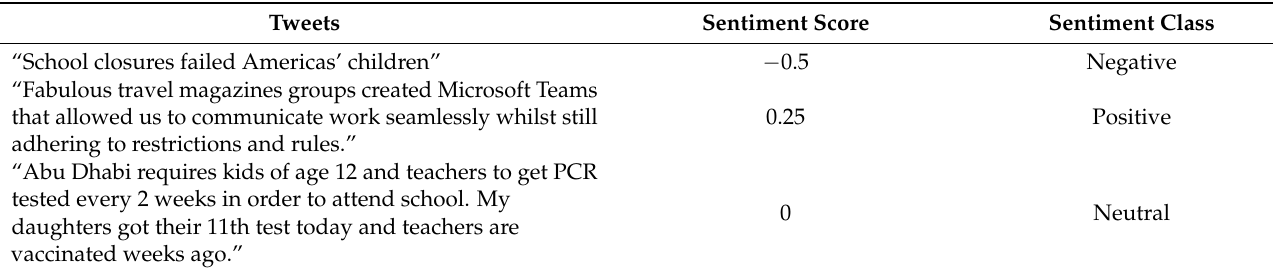
Table 4. Sentiment analysis results example.